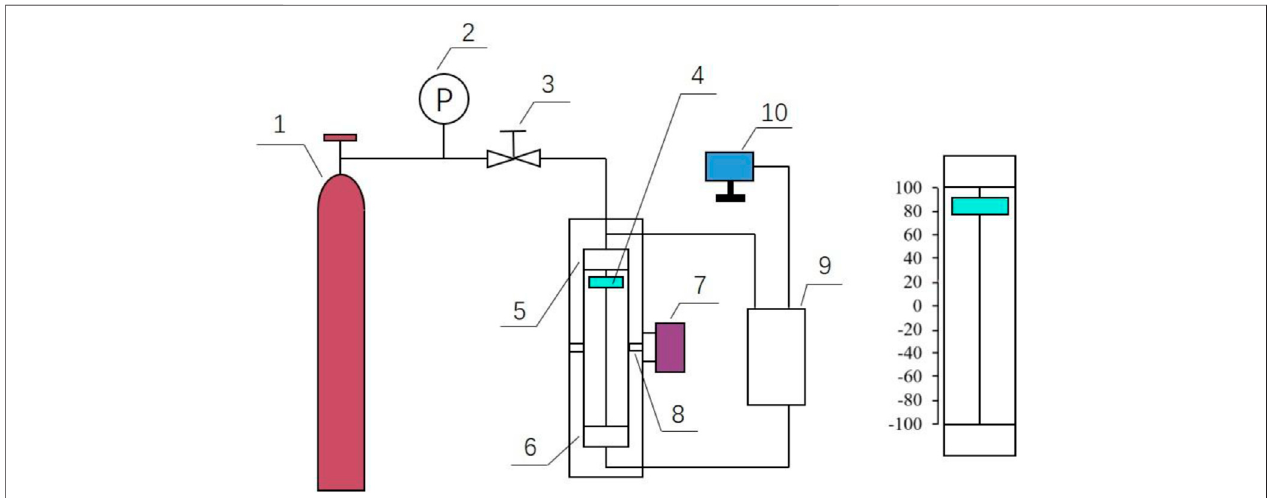
FIGURE 1 | Schematic of rocking cell. 1-methane gas cylinder, 2-pressure gauge, 3-valve, 4-slider, 5-temperature sensor, 6-pressure sensor, 7-swinging kettle motor, 8-swinging bar, 9-data acquisition box, and 10-t display.